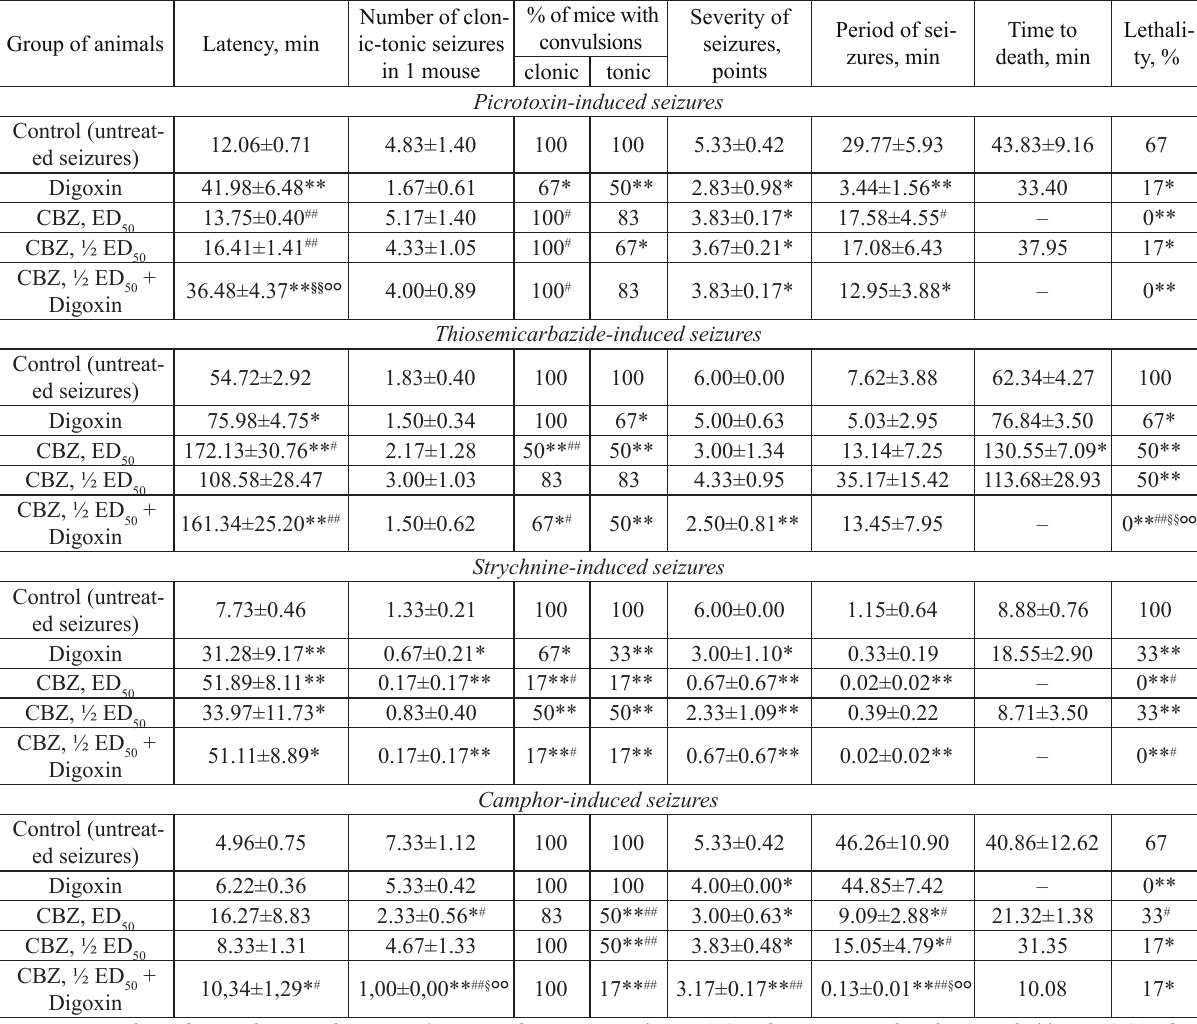
Anticonvulsant effect of digoxin, carbamazepine and their combination in the primary generalized seizures in